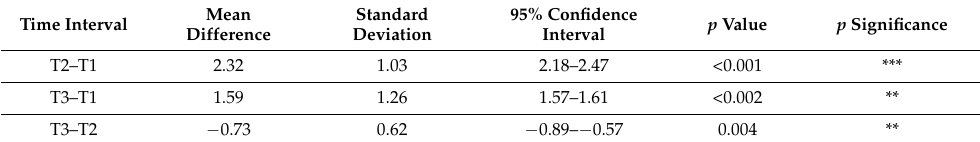
Table 8. Results of the mean differences (mm) of Nasal Floor 7 in the three time intervals.